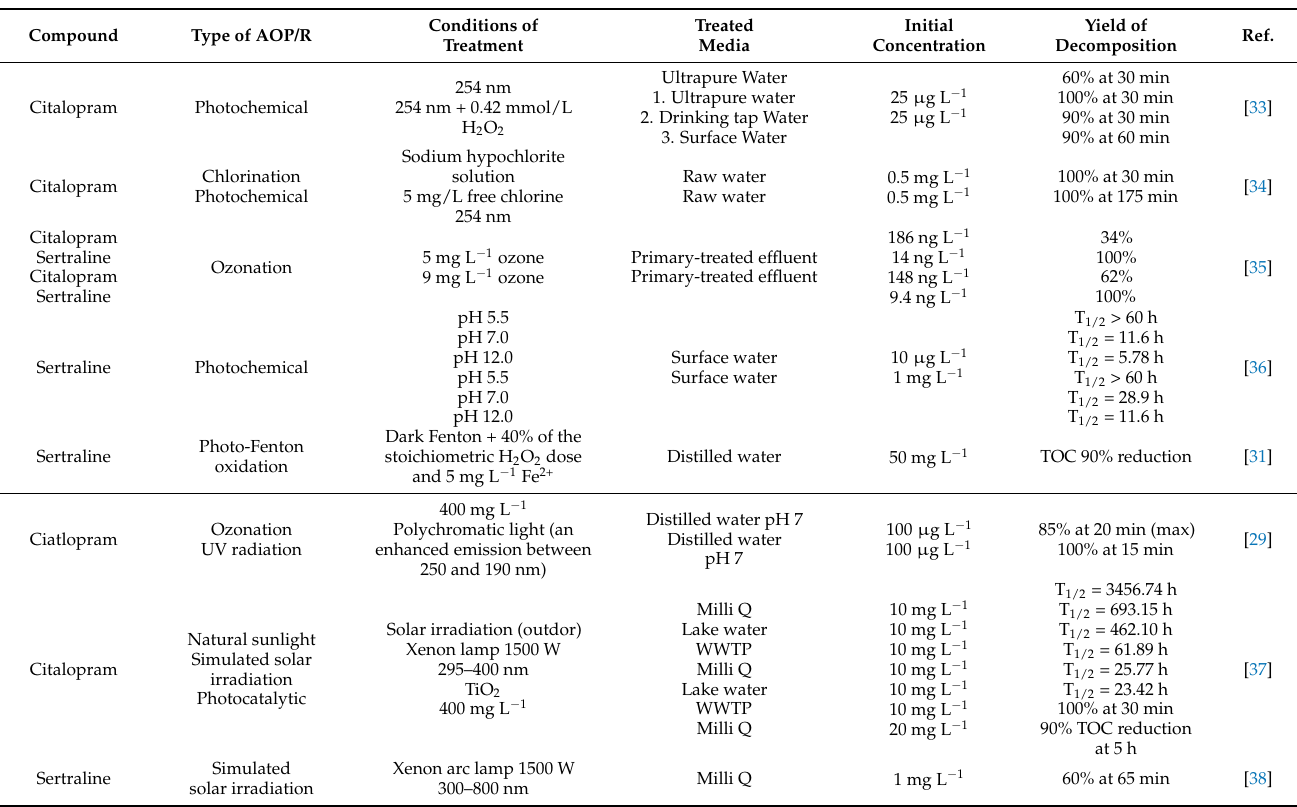
Table 1. Degradation sertraline and citalopram in different AOP